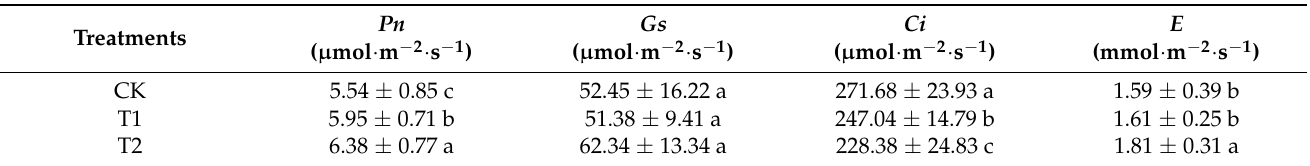
Table 2. Effects of different nutrition treatments on photosynthetic parameters of ‘Misty’ in a plant factory with artificial